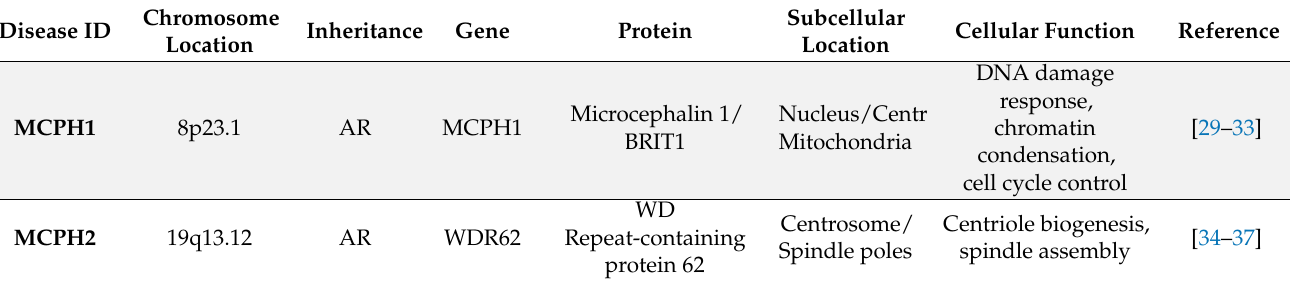
Table 1. Genes associated with human MCPH (January